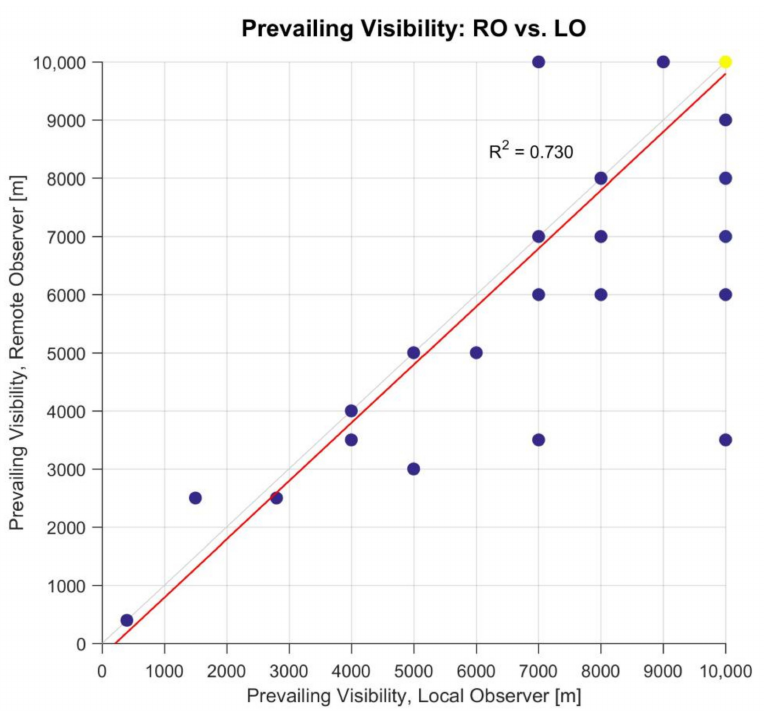
Figure 14. The same as Figure 13, but with the prevailing visibility determined by the local observers (LO) and the remote observers